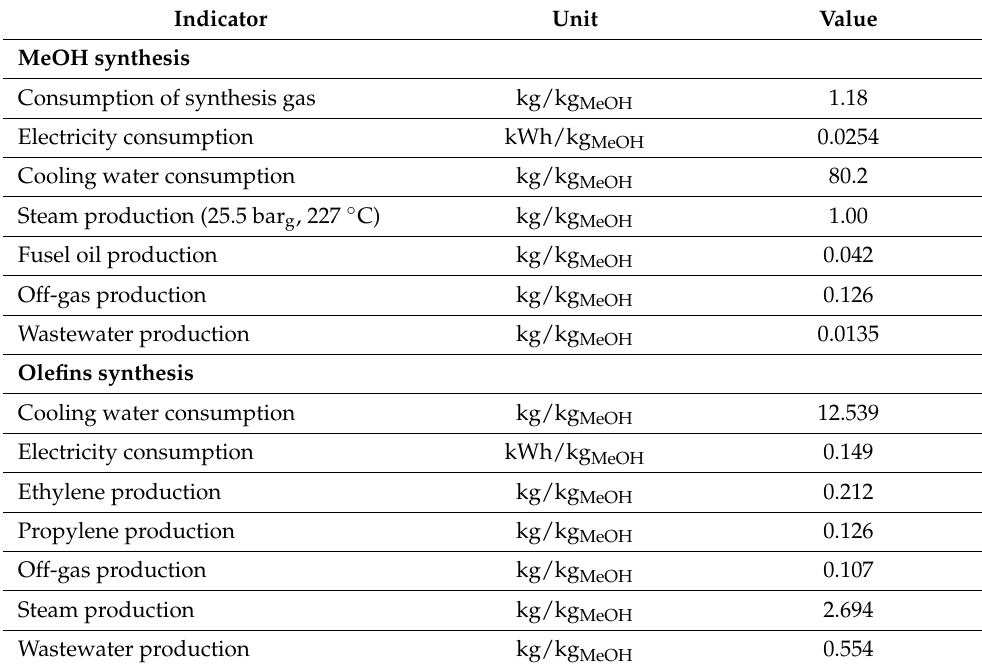
Table 3. Consumption and production basic indicators of methanol and